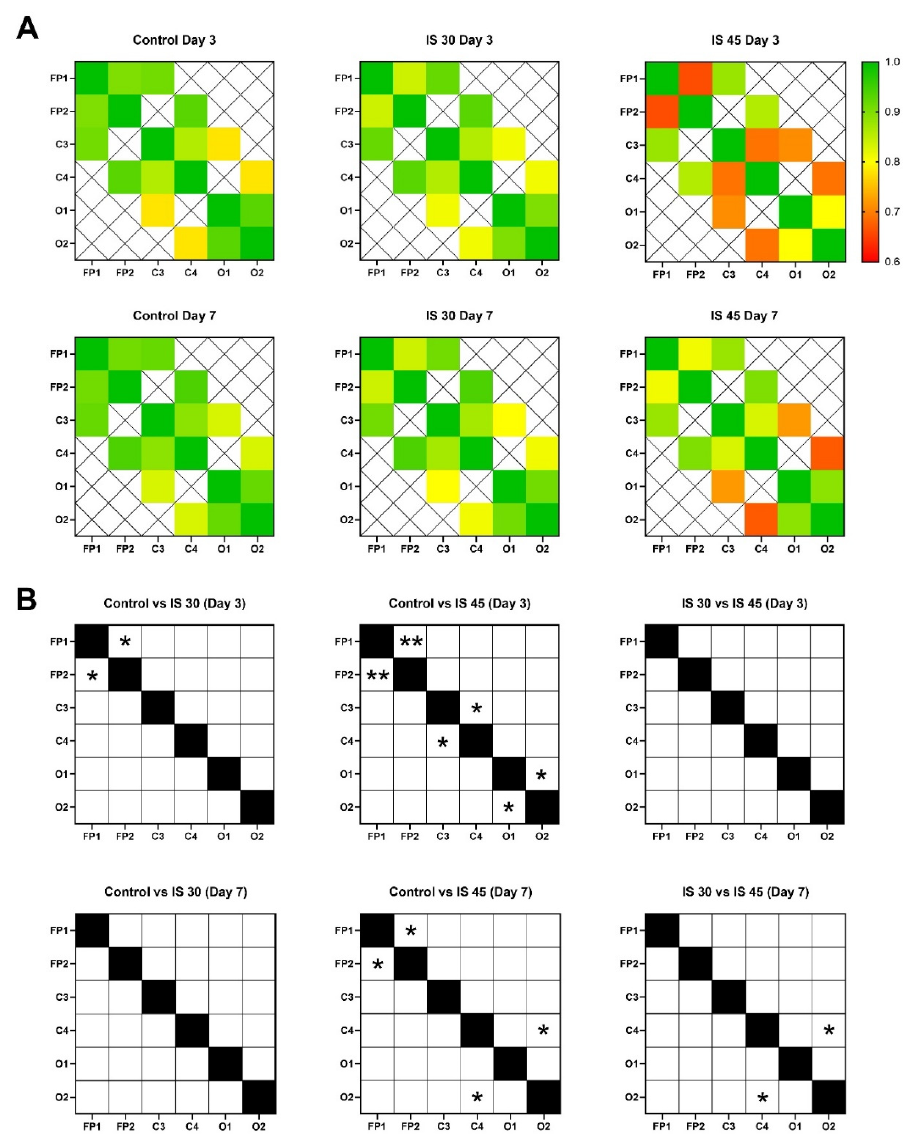
Figure 7. Cross ‐ correlation matrices ( A ) and statistical analysis results ( B ) for pairwise correlations FP1 ‐ FP2, C3 ‐ C4, O1 ‐ O2, FP1 ‐ C3, FP ‐ C4, C3 ‐ O1, and C4 ‐ O2 for all groups. Connectivity strength is color ‐ coded according to ( A ). Empty cells in ( B ) indicate no significant difference among the Control and IS 30 or IS 45 groups, whereas cells with * or ** indicate significant differences among groups. **, p < 0.01; *, p < 0.05.